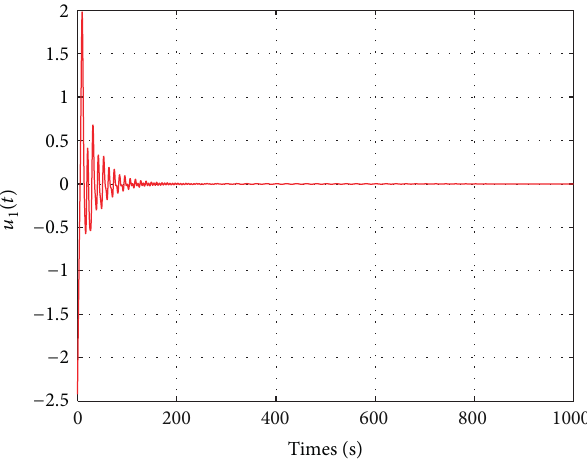
Figure 2: Displacement response of the first mass with and without FMPC.